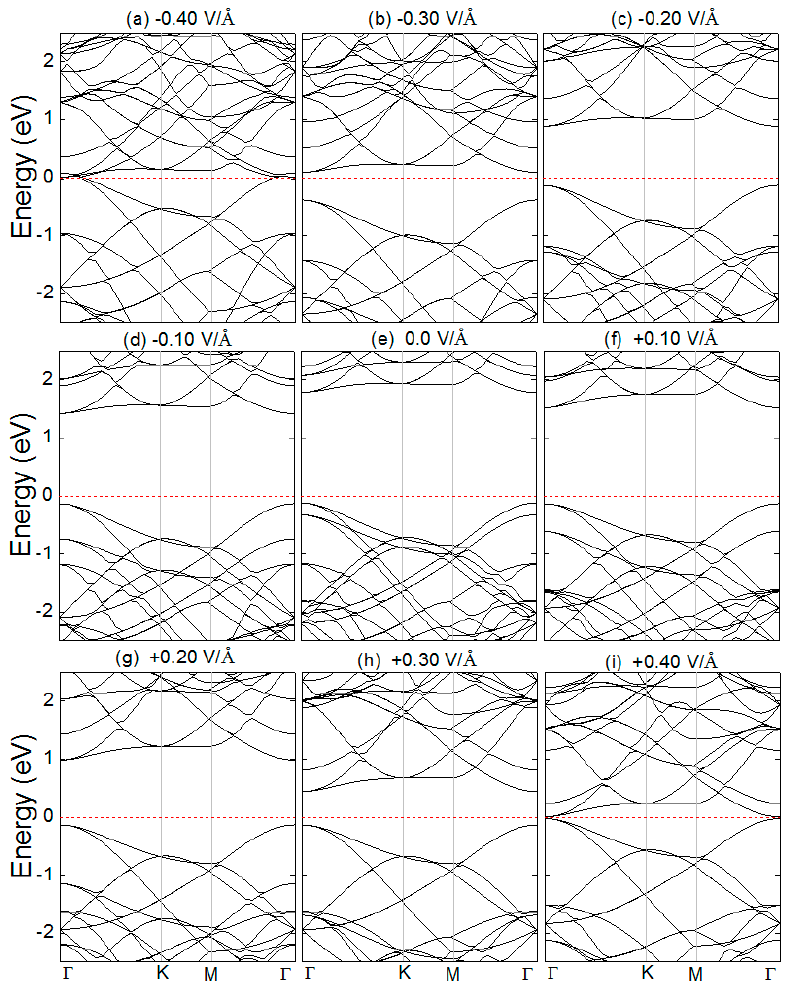
Figure 6. (Color online) The band structures of the SiC/GeC vdW heterostructures with different E-field strength. The Fermi levels are marked by the red dashed line.